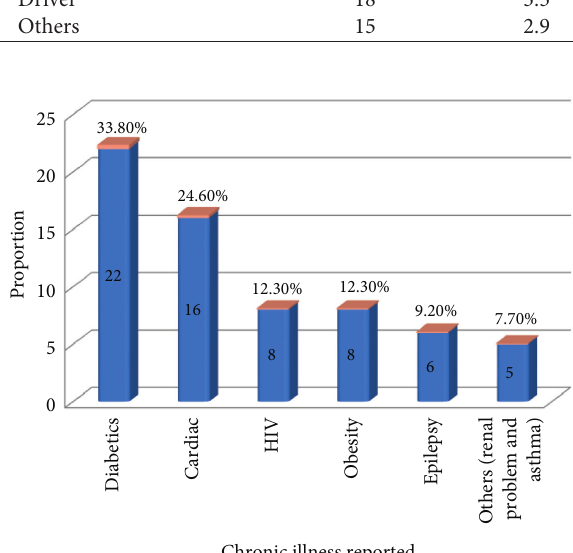
Figure 2: Types of chronic health problems childbearing age women have in Jinka town, Southern Ethiopia, 2018 ( n � 65).